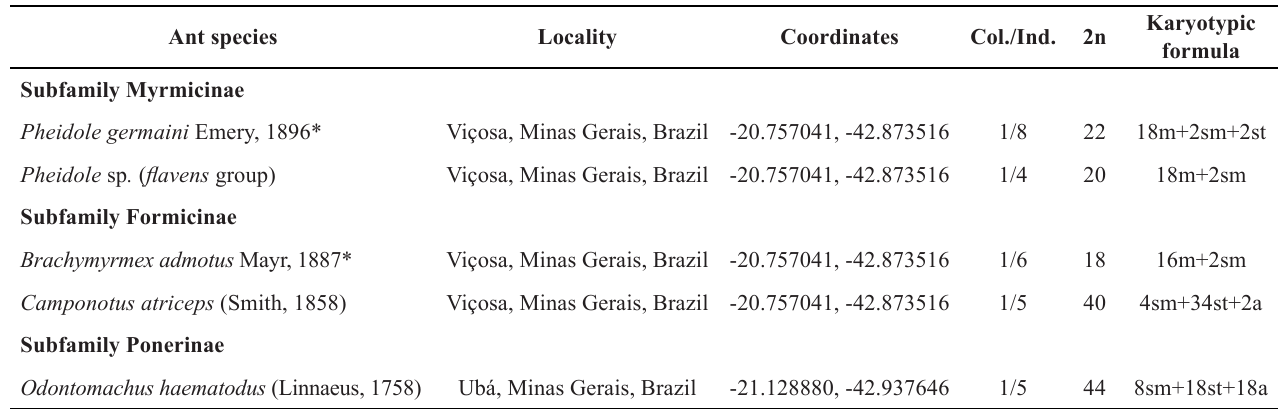
Table 1. Ant species from the Brazilian Atlantic rainforest karyotyped in this study. Collection site, sample size (number of colonies/ individuals), diploid chromosome number, and karyotypic